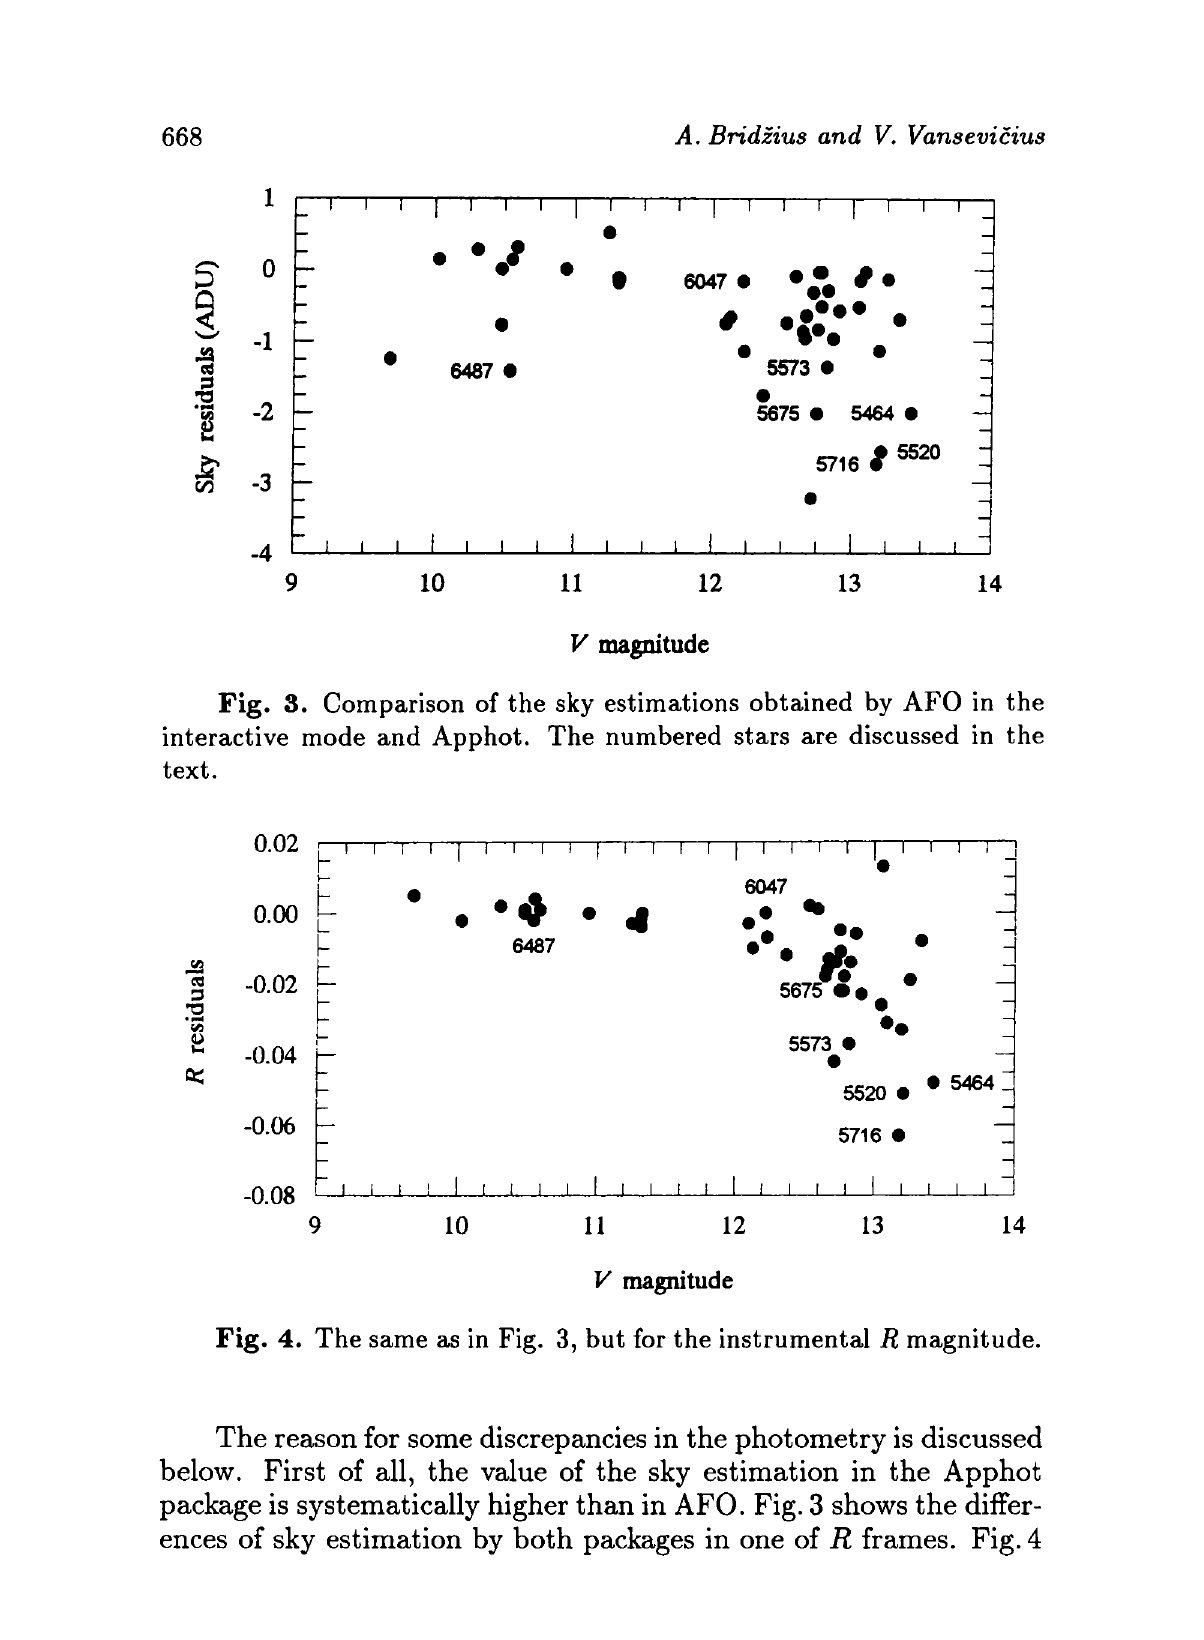
Fig. 4. The same as in Fig. 3, but for the instrumental R